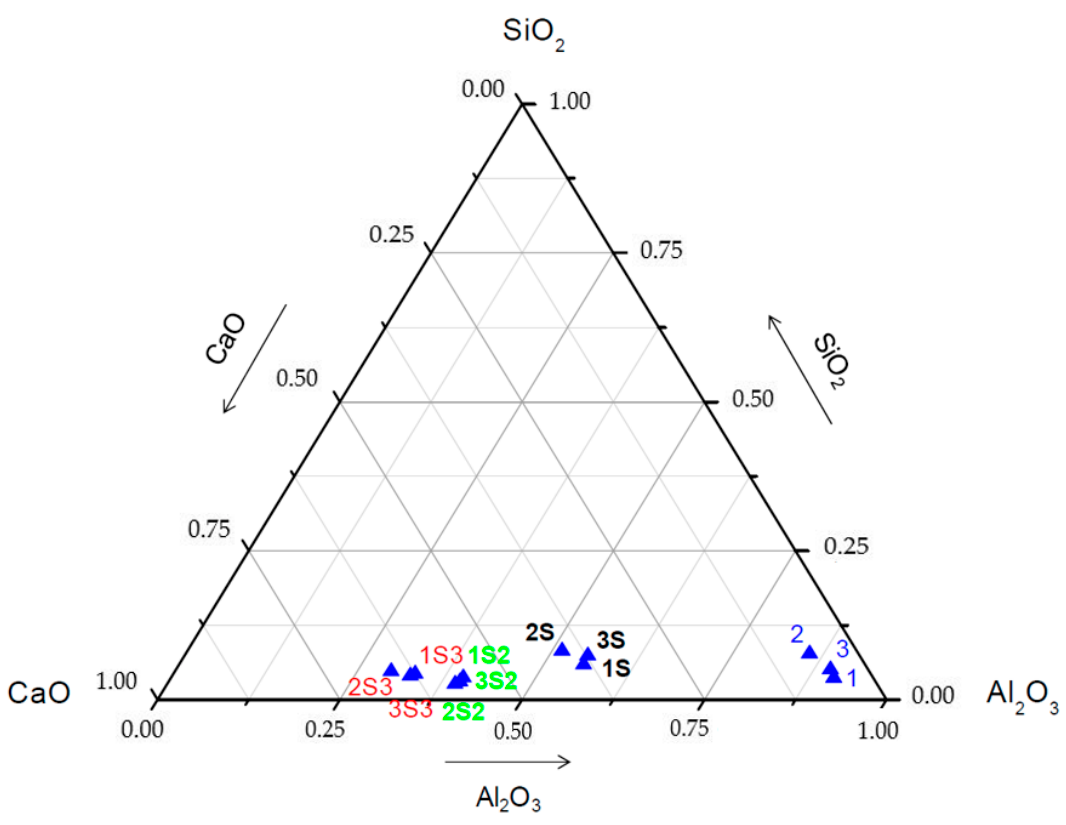
Figure 4. Diagram of phases of the Al 2 O 3 –SiO 2 –CaO system showing the initial drosses (points 1, 2, and 3), the sintered phases with molar ratio CaO / Al 2 O 3 1:1 (points 1S, 2S, and 3S), CaO / Al 2 O 3 1:2 (points 1S2, 2S2 and 3S2) and sintered phases with molar ratio CaO / Al 2 O 3 1:3 (points 1S3, 2S3, and 3S3). Materials 2018 , 11 , x FOR PEER REVIEW